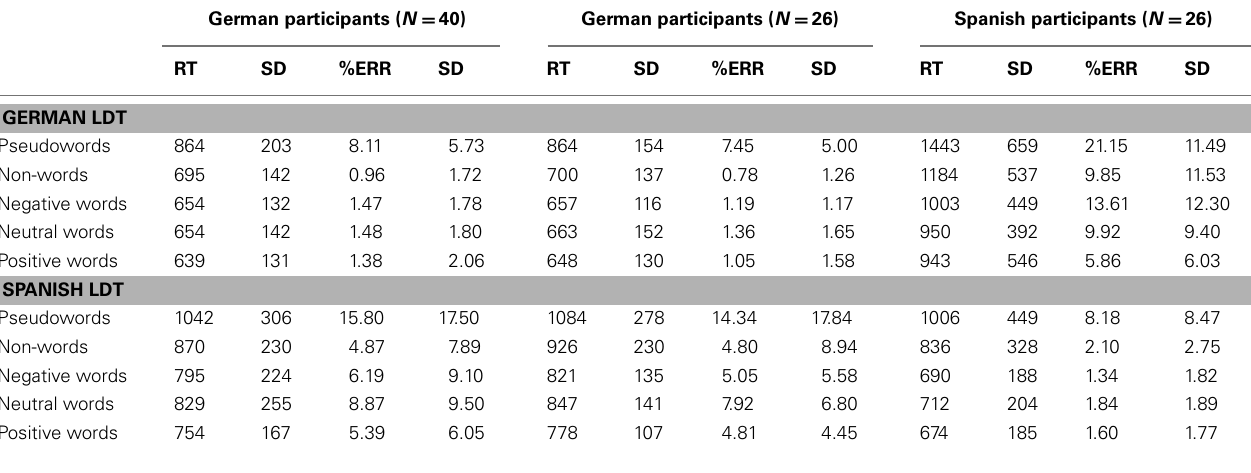
Table 3 | Means and SD of response latencies (RT) and error percentages (%ERR) for words and non-words in the German and Spanish lexical decision task